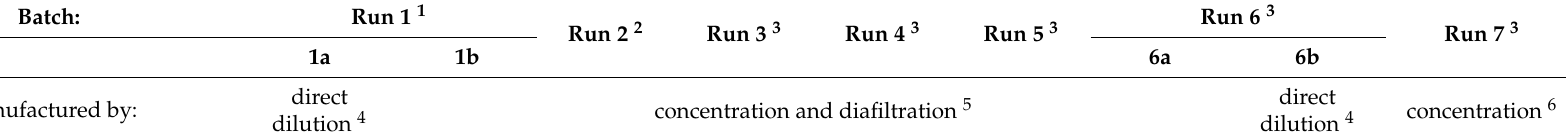
concentration and diafiltration